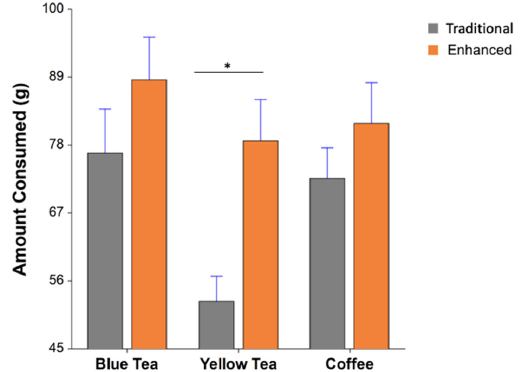
Figure 7. Average amount consumed in grams. Whiskers represent the SEM.